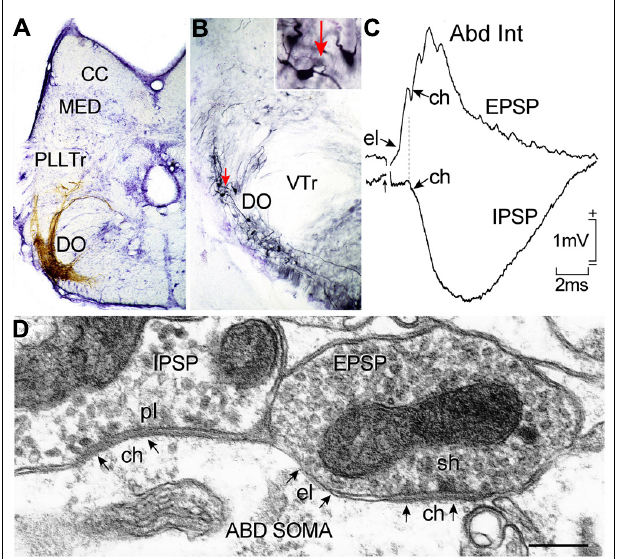
FIGURE 7 | Horizontal canal termination, second order vestibular neuron location and morpho-physiological correlates of excitatory and inhibitory vestibular inputs to abducens motoneurons andAI neurons. Nissl-stained transverse section through a goldfish hindbrain illustrating biocytin-labeled horizontal canal afferent terminations (A) and vestibular neurons in the DO (B) that were retrogradely labeled from the contralateral ABD nucleus; a labeled neuron (red arrow) in (B) is shown at higher magnification in the inset. Crossed EPSP and uncrossed IPSP in an abducens internuclear neuron following electrical stimulation of the horizontal semicircular canal nerve on both sides, respectively (C) ; responses are mediated by electrical (el); and/or chemical synapses (ch) between inhibitory (pl) and excitatory vestibular (sh) axonal terminations on abducens neurons as illustrated in the electronmicroscopic image (D) . CC, cerebellar crest; DO, descending octavolateral nucleus; MED, lateral line medial nucleus; pl, pleiotropic; PllTr, posterior lateral line tract; sh, spheroidal;VTr, descending tract of theVth cranial nerve;VTr, descending tract of theVth cranial nerve. Data in (C,D) adapted from Graf etal. (1997) and Green etal. (1997).